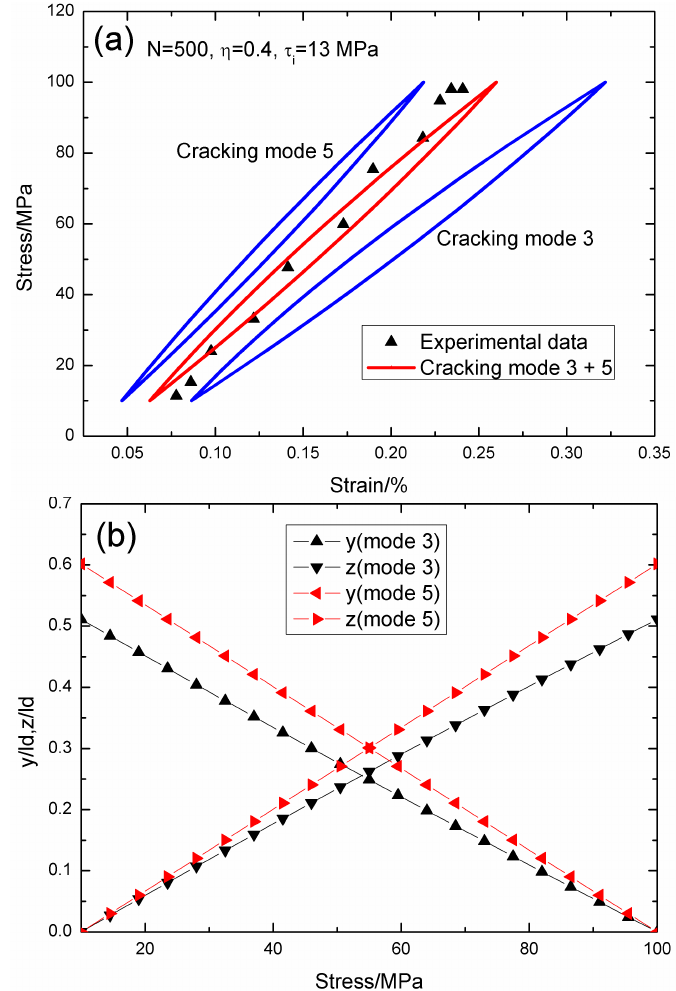
Figure 8. ( a ) The theoretical and experimental hysteresis loops; and ( b ) the interface slip lengths, i.e. , y / l d and z / l d , of matrix cracking modes 3 and 5 of 2D woven SiC/SiC composite under σ max = 100 MPa at 1000 °C in air and a loading frequency of 1.0 Hz when N =